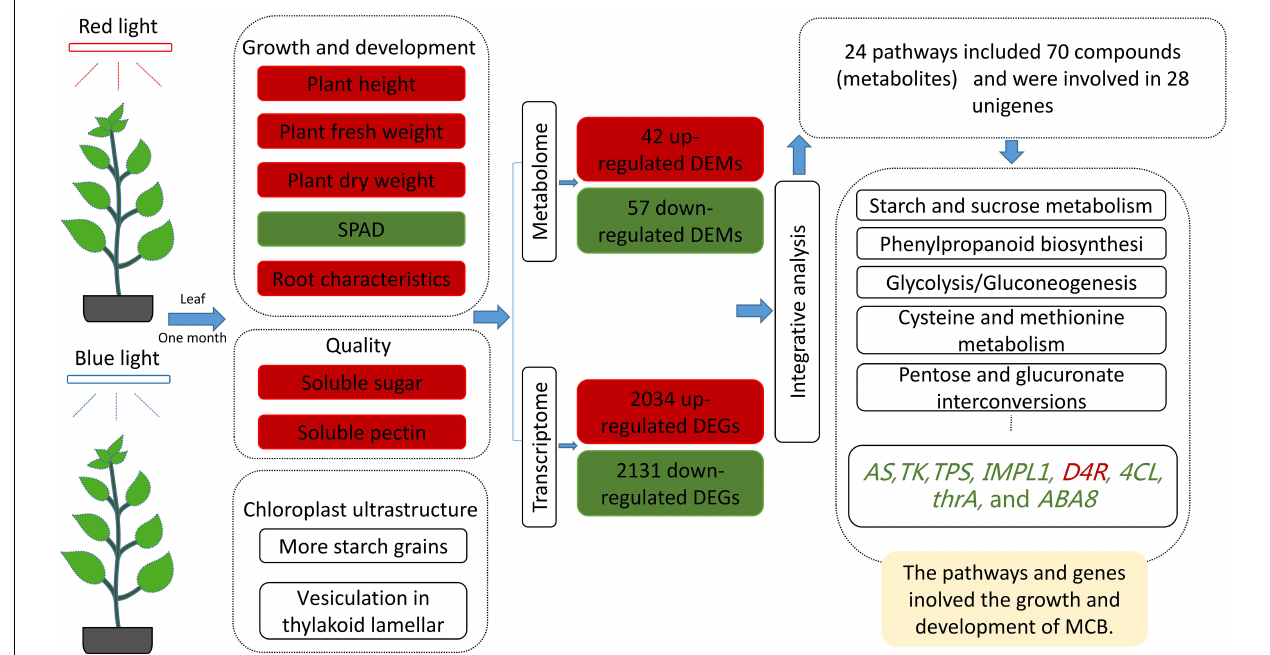
FIGURE 8 | Overview of the red light and blue light regulating the growth and development of MCB. Red boxes and words indicated upregulation; Green boxes and words indicated downregulation.